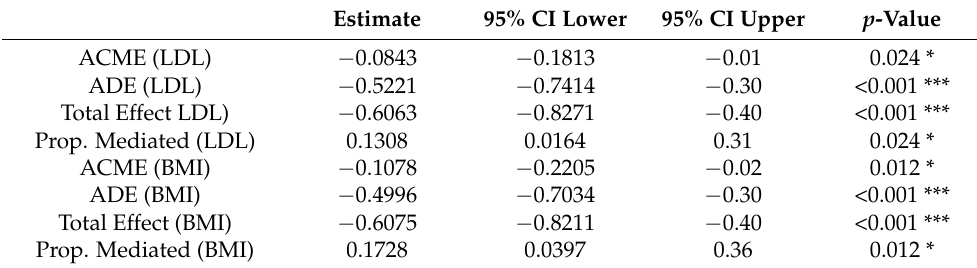
Figure 7. Decomposed Mediation Analysis plot: ACME = Average Causal Mediation Effect, ADE = Average Direct Effect, LDL = Low Density Lipoprotein, BMI = Body Mass Index. Table 4. Causal Mediation Analysis, Quasi-Bayesian Confidence